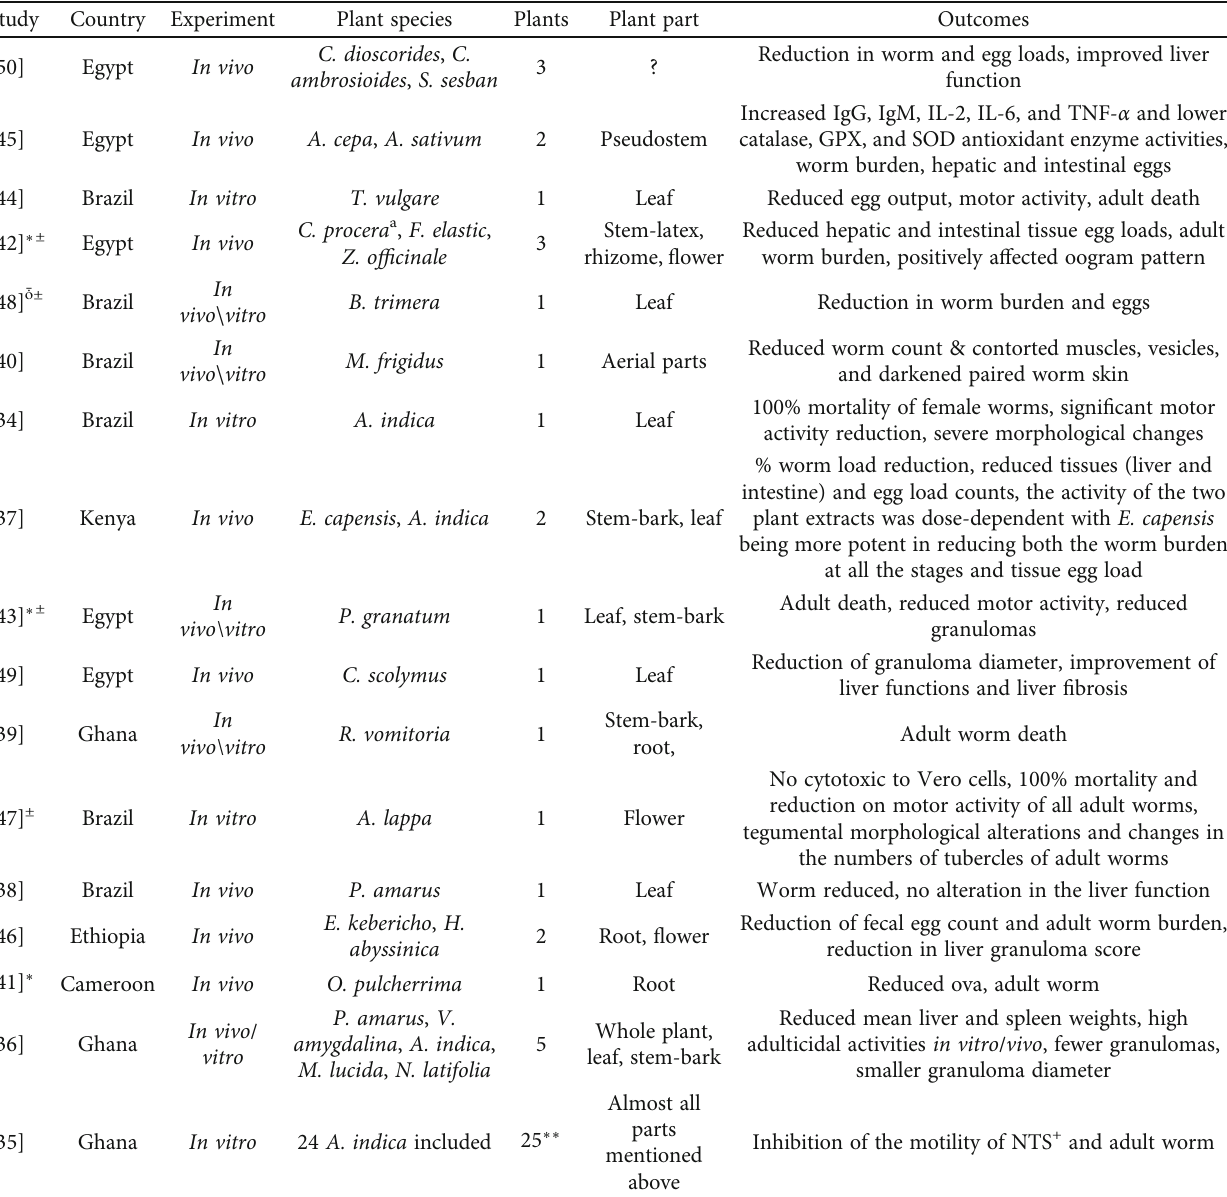
Table 1: Data extracted from the selected